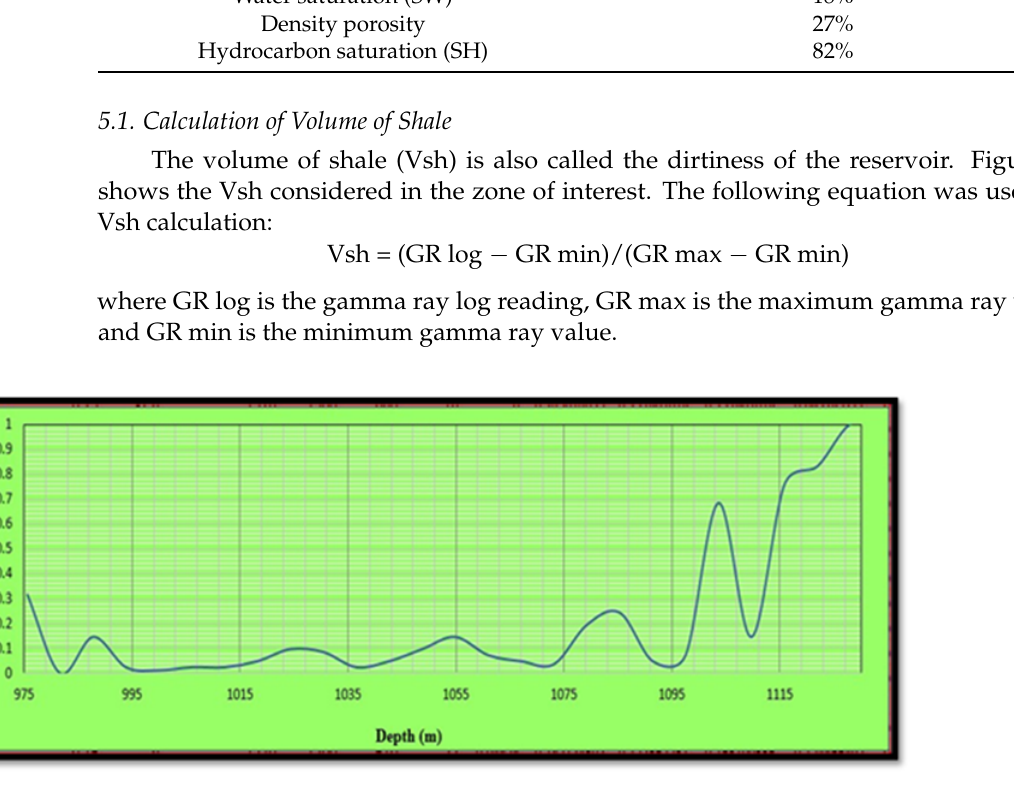
Figure 16. Volume of shale for selected zone.